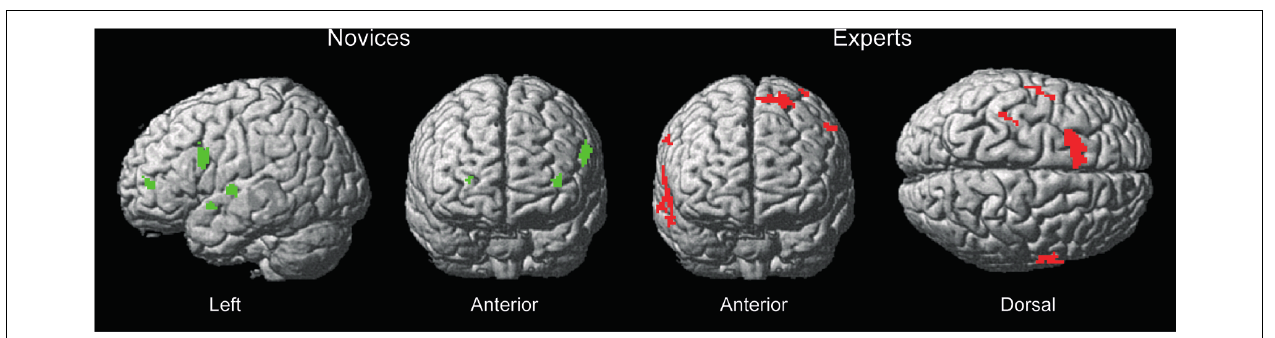
FIGURE 3 | Brain regions recruited for novices and experts during action decision of successful trials compared to unsuccessful trials. Novices rely on pre-frontal regions whereas experts rely on motor/pre-motor regions of